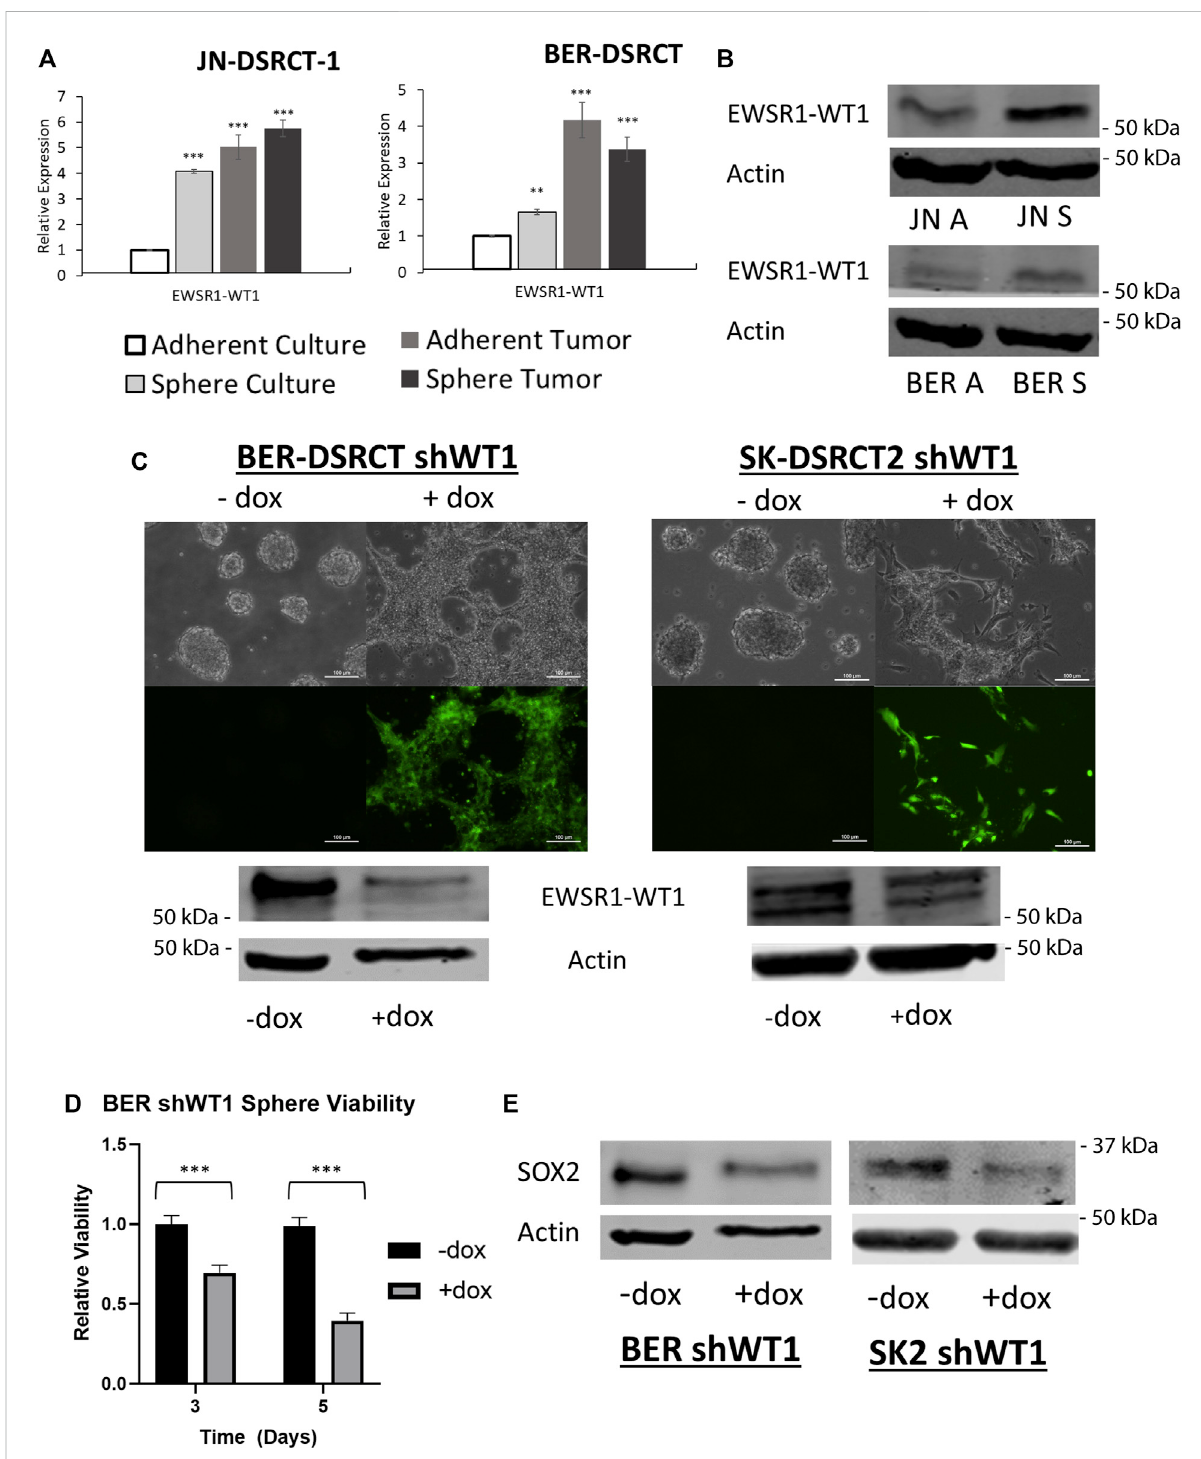
EWSR1-WT1 isnecessaryfor DSRCT CSCcharacteristics. (A) Relative expressionof EWSR1-WT1 mRNAinJN-DSRCT-1 andBER-DSRCTcells in adherentculture,sphereculture,xenograft tumorsderivedfromadherentculture,orxenograft tumorsderivedfromspherecultureassessed via RT- qPCR( n =3,* p < 0.05,** p < 0.01,*** p < 0.001,Student ’ s t -test). (B) Westernblotof EWSR1-WT1 proteinlevelsinJN-DSRCT-1andBER-DSRCTcells in adherent and sphere culture. (C) Dox-inducible shWT1 system induces selective expression of EGFP (as shown via microscopy) and knockdown of EWSR1-WT1 protein (as shown via Western blot) in BER-DSRCT and SK-DSRCT2 cells only in the presence of dox. This knockdown reduced tumorsphere formation as shown via microscopy. (D) Relative viability of BER-DSRCT shWT1 in sphere culture for 3 and 5 days with or withoutdoxaddition( n =4,*** p < 0.001,Student ’ s t -test). (E) WesternblotofSOX2proteinlevelsinBER-DSRCTshWT1andSK-DSRCT2shWT1cells in sphere culture for 7 days with or without dox